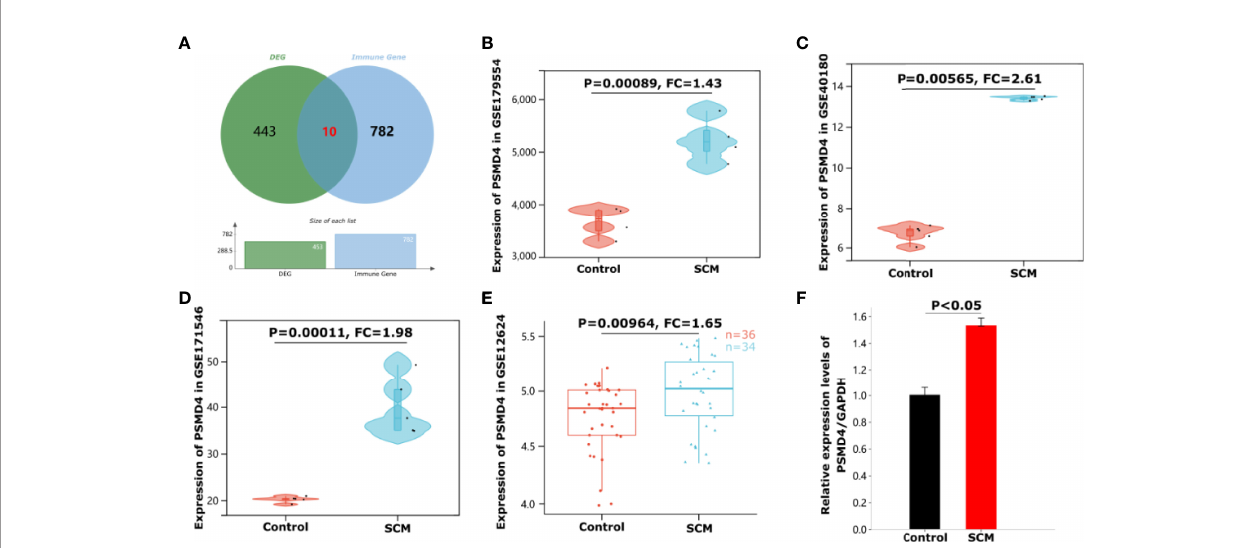
FIGURE 6 | Identi fi cation and validation of immune-related hub genes PSMD4 in SCM. (A) Venn diagram showing 10 intersection genes of differential genes and immune cell marker genes. (B) The violin plot represents the expression of PSMD4 in mice cardiomyocytes in the dataset GSE179554. (C) The violin plot represents the expression of PSMD4 in mice cardiomyocytes in the dataset GSE40180. (D) The violin plot represents the expression of PSMD4 in mice cardiomyocytes in the dataset GSE171546. (E) The box plot represents the expression of PSMD4 in human peripheral whole blood in the dataset GSE12624. (F) Detection of PSMD4